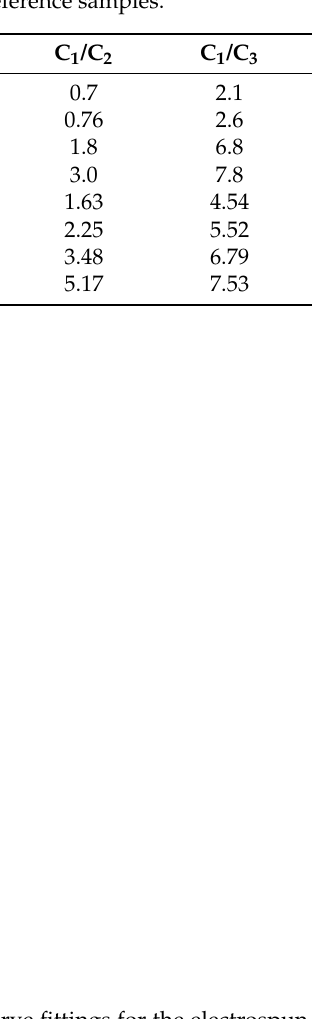
Table 1. Atomic ratios for electrospun scaffolds and reference samples.